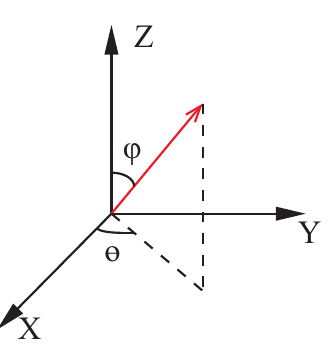
Figure 2. Spherical coordinates of r J